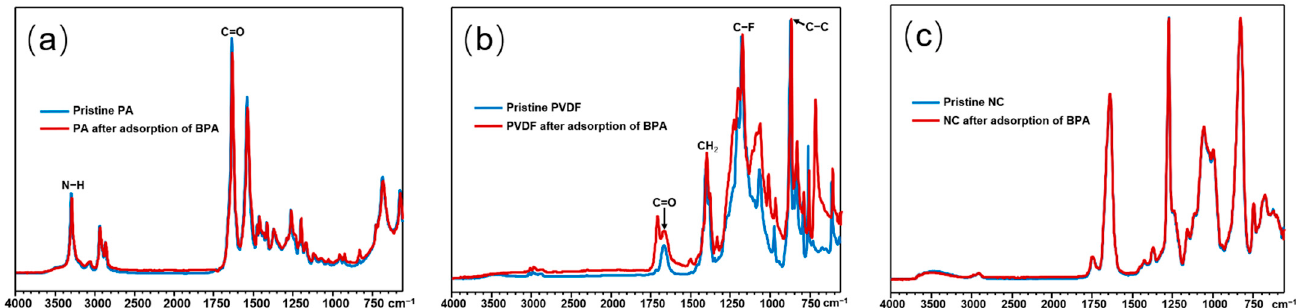
Figure 7. EDS and elemental mapping of the PA MFMs ( a ), PVDF MFMs ( b ), and NC MFMs ( c ).